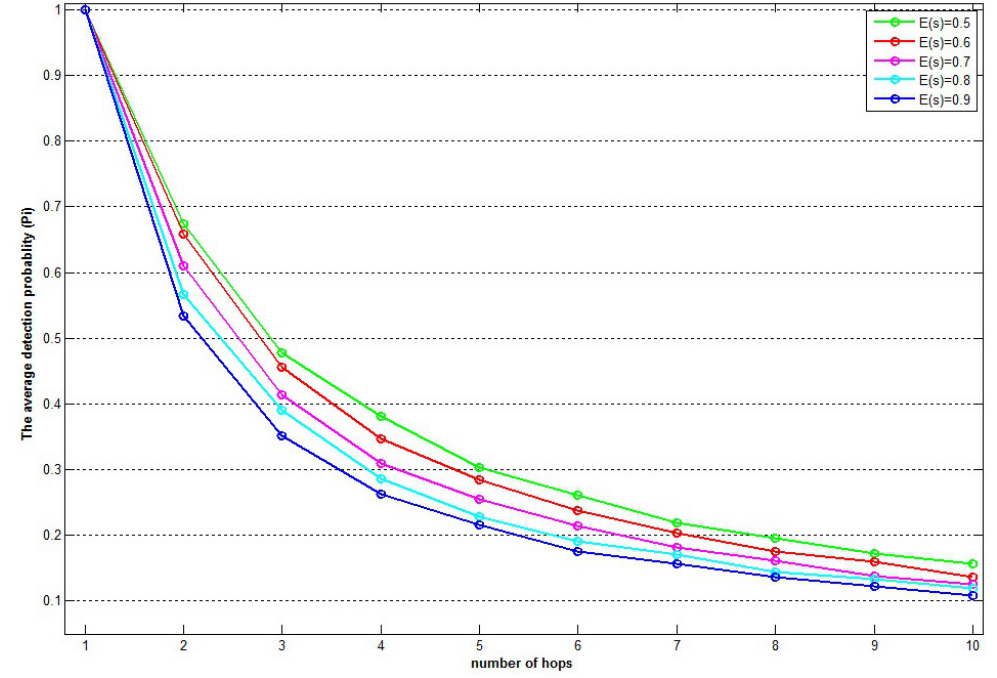
Figure 13. The effect of cluster size on the detection probability of the D-IDS for various sleep rates while the packet loss rate is